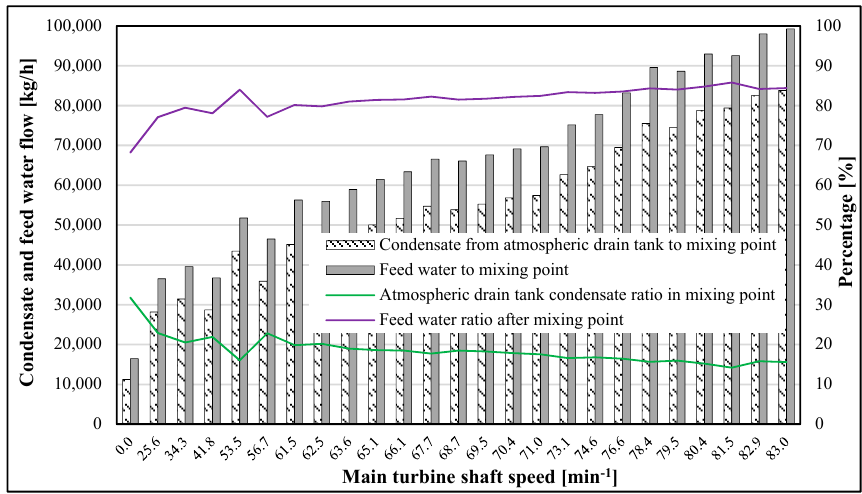
Figure 6. Atmospheric drain tank condensate ratio in mixing point with feed water with main turbine load variation.